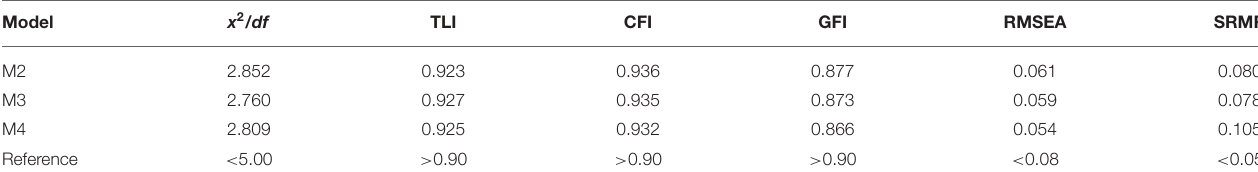
TABLE 5 | Fitting indicators of nested model comparison.